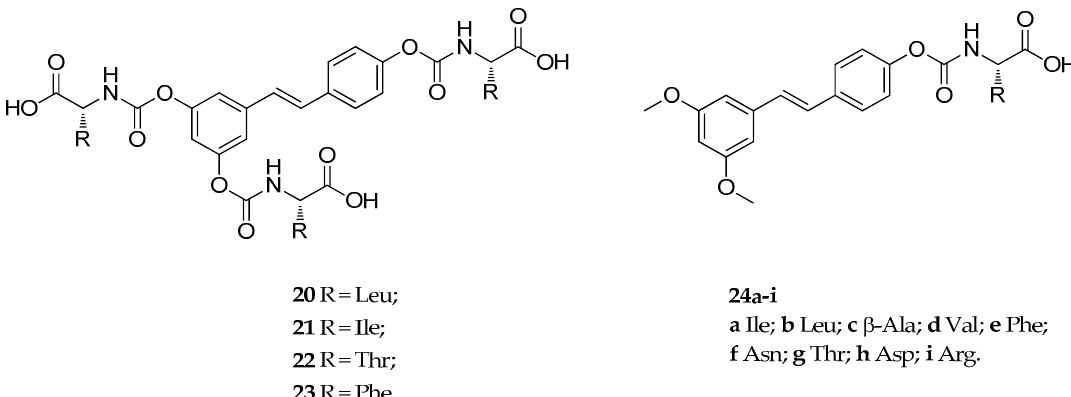
Figure 11. Chemical structures of N -monosubstituted carbamate amino acidic prodrugs 20 – 23 , and 24a – i . Table 5. Summary of RSV prodrugs for systemic delivery and their stability properties.